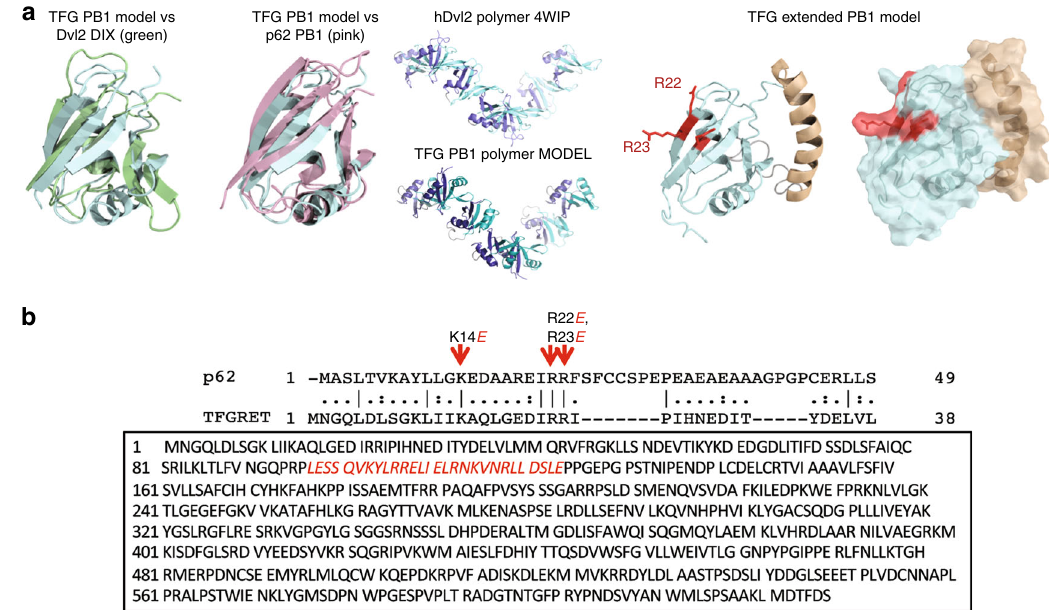
Normal, tumor and metastasic (from lymph node) tissue were taken for further analysis. A procedure involving a total thyroidectomy with therapeutic central and right lateral lymph node dissection (neck dissection, levels II – VII) was performed. The lymph node was chosen because the macroscopic appearance was clearly metastatic. Histology described a multifocal, bilateral follicular differentiated papillary thyroid carcinoma (pT4b, pN1, M1 (lung), Stage II, Classi fi cation according to 1997). All other tissue samples were provided by the tissue bank of the